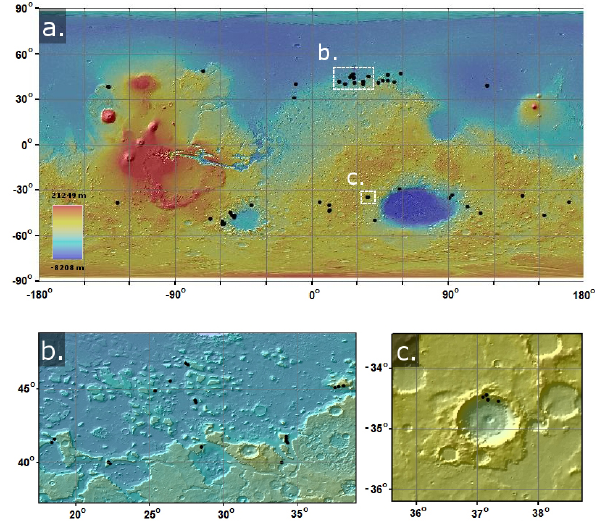
Figure 5. The distribution of crevassed GLFs on Mars (a) , with expansions of GLF clusters in Deuteronilus Mensae (b) and western Hellas Planitia (c)